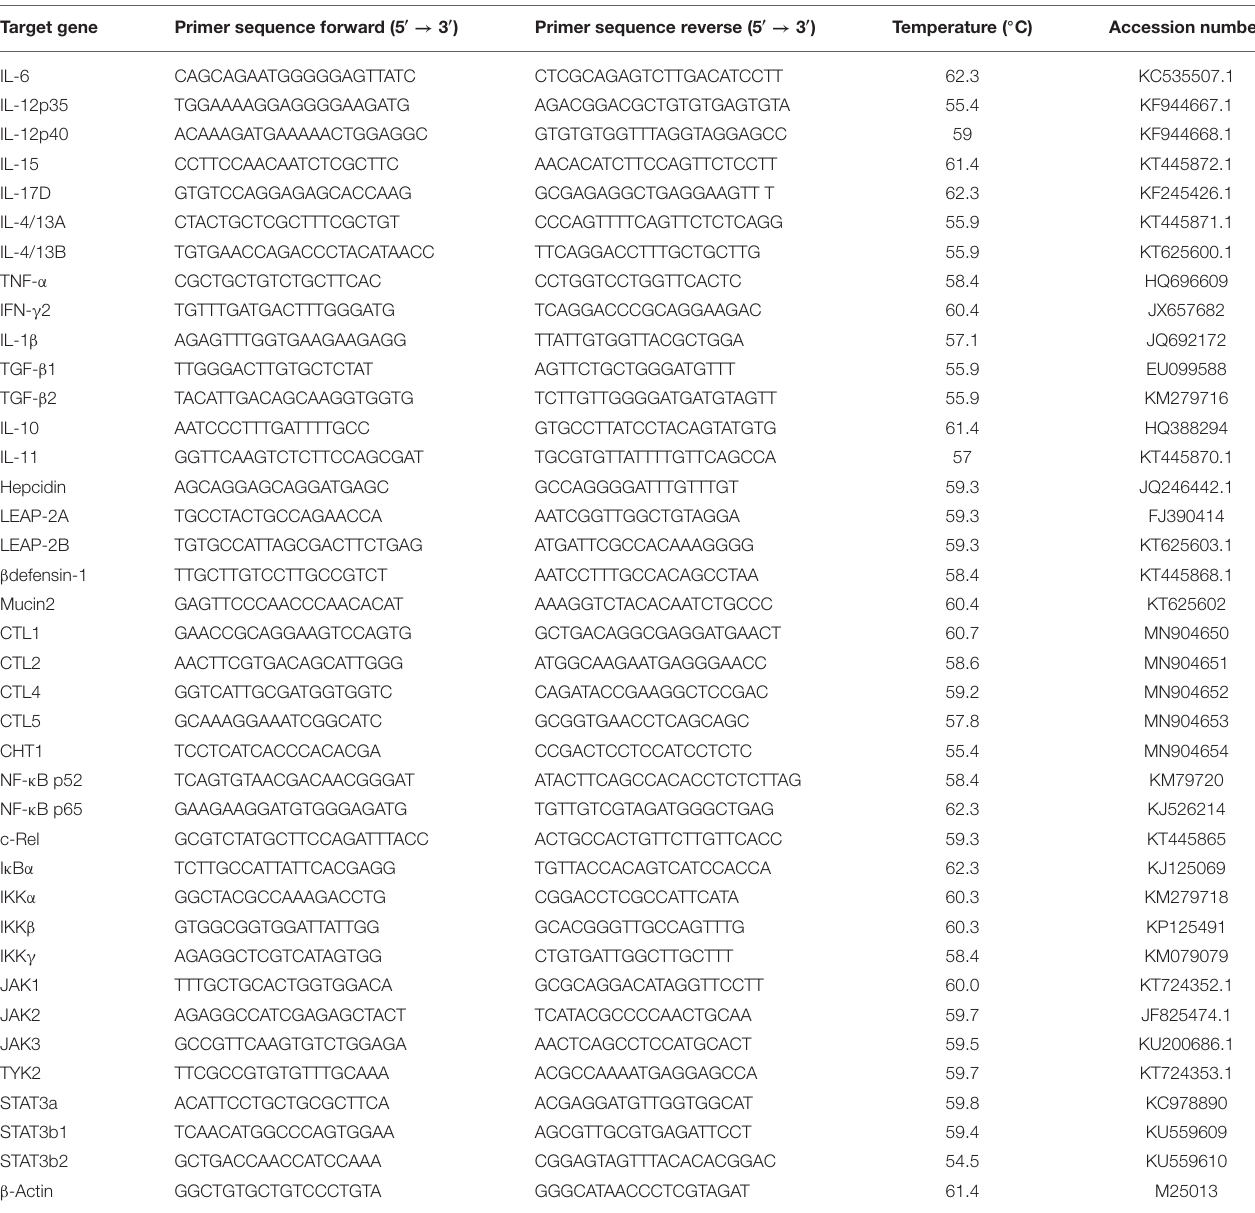
TABLE 2 | Real-time PCR primer sequences. Target